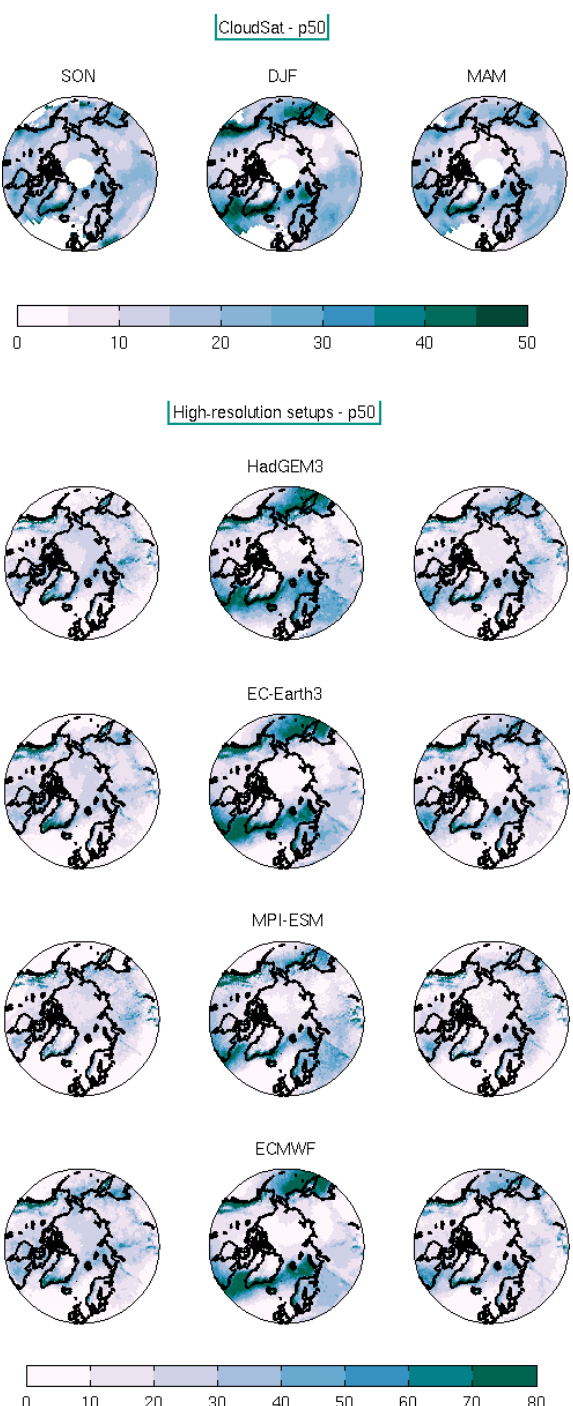
Figure 2. Same as Fig. 1 but at the 50th percentile threshold.